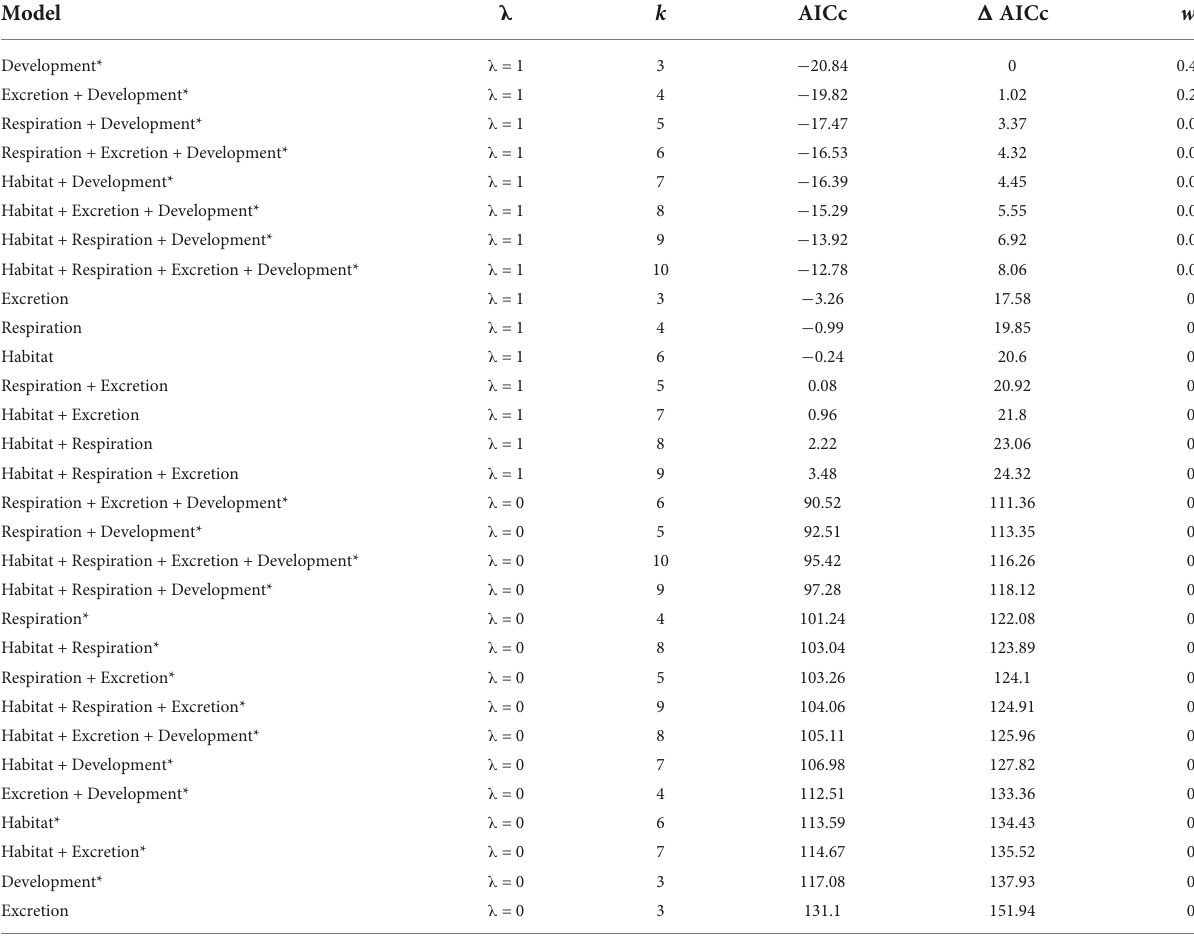
TABLE 2 Results for the complete Decapoda dataset for phylogenetic generalized least-squares (PGLSs) models to explain variation in genome size as a function of habitat, respiration, excretion, developmental mode and their combinations.